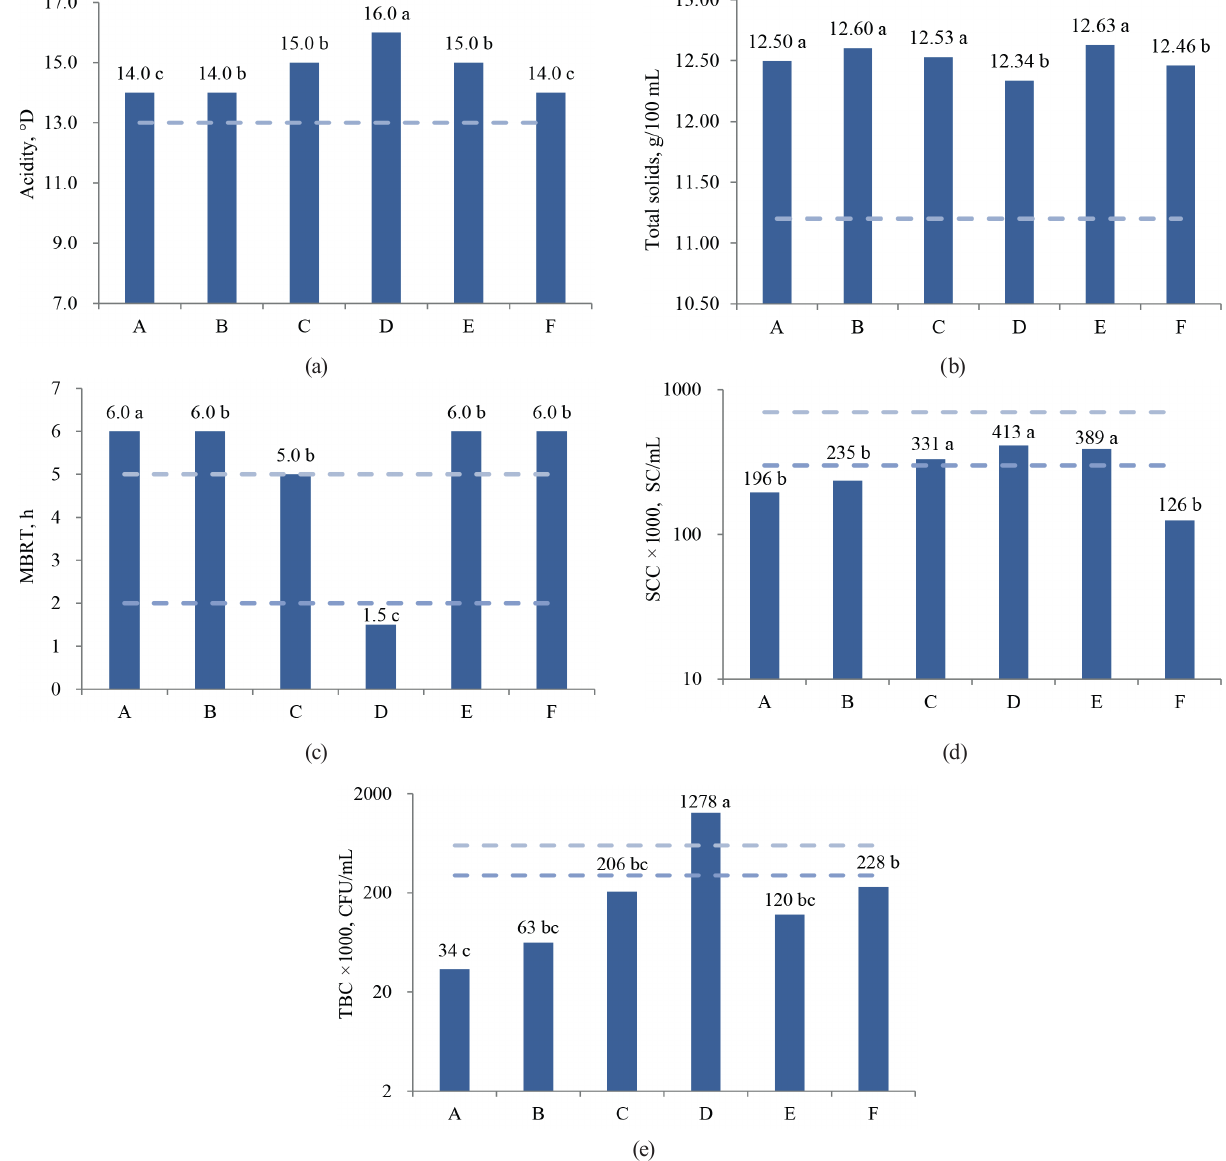
Figure 2 Average values of (a) acidity (°D), (b) total solids (g/100 mL), (c) MBRT (h), (d) SCC (SC/mL), and (e) TBC (CFU/mL) for each association during eight months of the study. The dashed red lines represent the values that delimit the thresholds of good quality, regular quality and poor quality of milk or the minimum acceptable values by the Ecuadorian standards. Different letters mean statistically significant differences ( P <